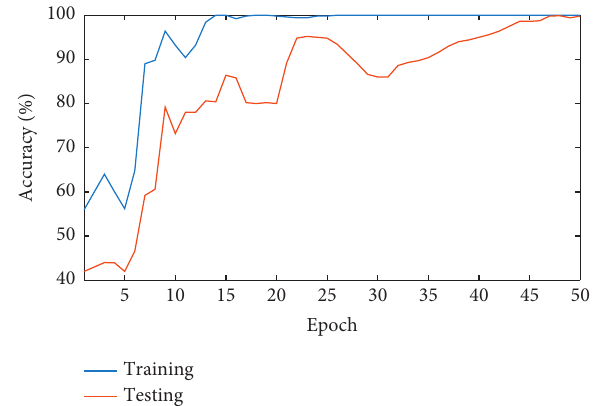
Figure 5: Changes in training and testing